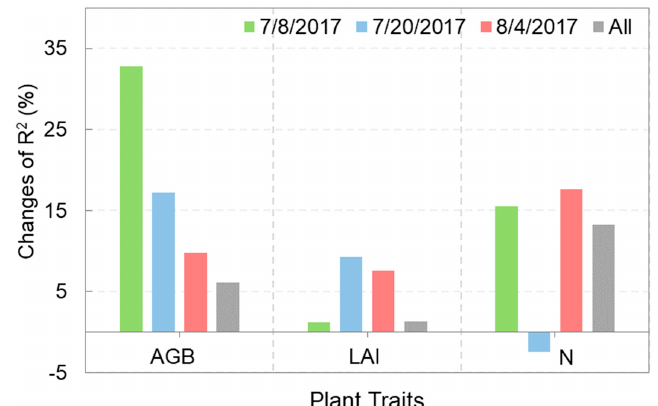
Figure 10. Percentage changes of R2 for AGB, LAI, and N estimation when using satellite and UAV data fusion compared to only using satellite data on different development stages (Note: all estimation results here are based on ELR method); ‘All’ represents the result when combing all data samples from different dates. The combination of satellite and UAV data improved the model accuracies in most cases, except for N estimation when the data was from July 20, 2017.